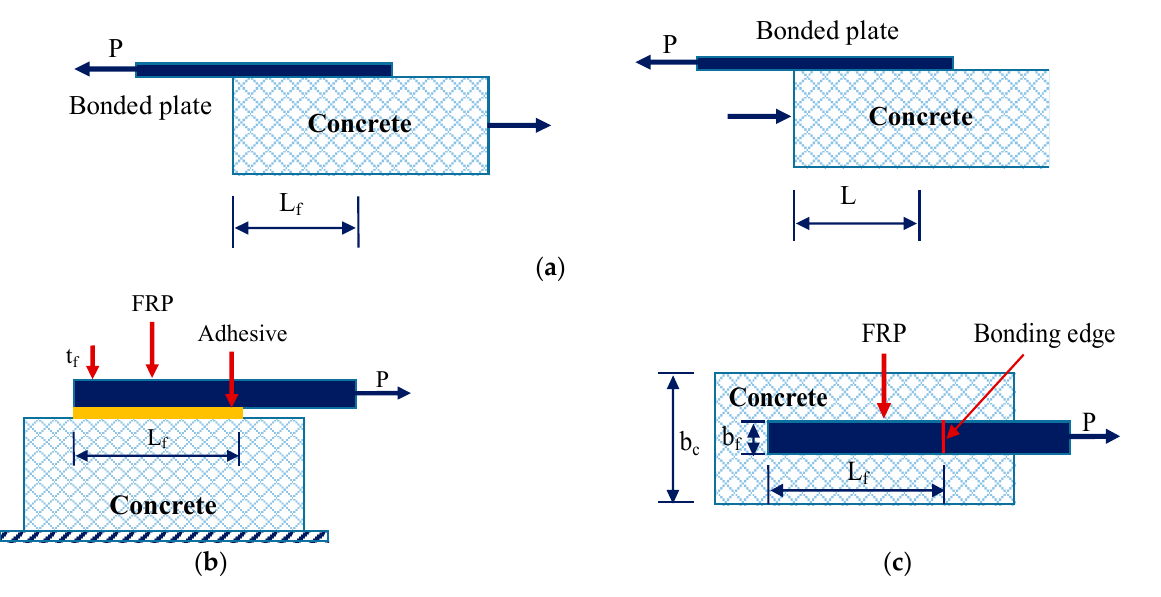
Figure 1. Single-lap shear test: ( a ) single-lap shear test arrangement; ( b ) elevation view; and ( c ) plan view.